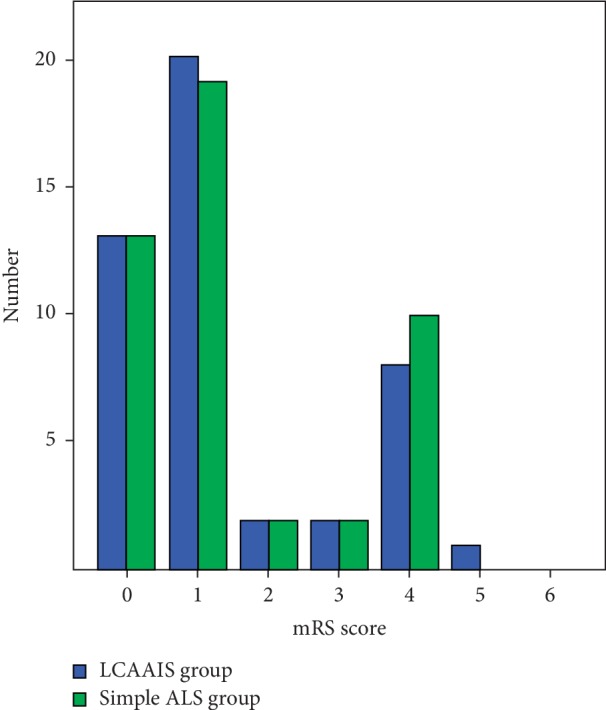
Comparison of mRS scores between the LCA-AIS group and simple AIS group.